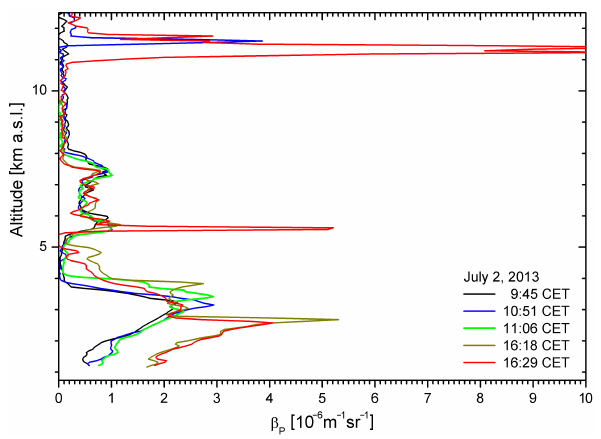
Figure 6. Ozone mixing ratios for 2 July 2013; please note the mod- erate mixing ratio in the fire plume ranges between about 5.5 and